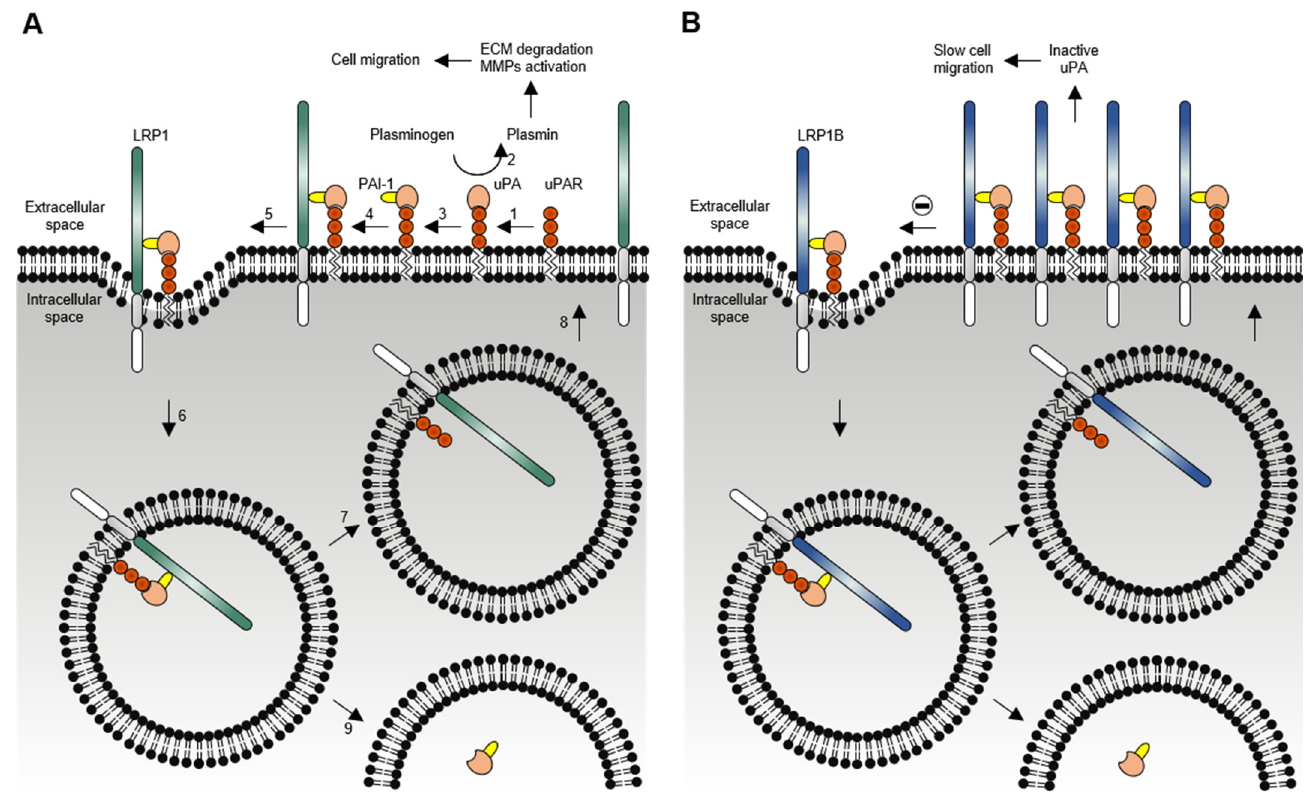
Figure 5. Model depicting the differential functions of LRP1 (A) and LRP1B (B) in endocytosis of uPAR . ( A ) uPAR LRP1-mediated endocytosis: (1) uPA binds to uPAR; (2) active uPA catalyzes the conversion of plasminogen to plasmin, which cleaves and activates matrix metalloproteinases (MMPs); both plasmin and MMPs degrade many extracellular matrix (ECM) components; (3) PAI-1 binds to and inhibits uPA; (4) binding of PAI-1 promotes binding of LRP1; (5) fast distribution of the quaternary complexes (uPA/PAI-1/uPAR/LRP1) to clathrin-coated pits; (6) the quaternary complexes are internalized and delivered into early endosomes; (7) sorting of LRP1 and uPAR into recycling vesicles; (8) recycling of unoccupied forms of LRP1 and uPAR back to the cell surface; (9) uPA/PAI-1 complexes are trafficked through late endosomes to lysosomes for degradation. ( B ) Similar to LRP1, LRP1B forms complexes with uPA/PAI-1/uPAR. However, slow endocytosis of LRP1B causes a slow elimination of occupied uPAR from the cell. As a result, occupied uPAR accumulates on the cell surface, functional uPAR is not regenerated effectively, uPA proteolytic activity is scarce, and cell migration is diminished.